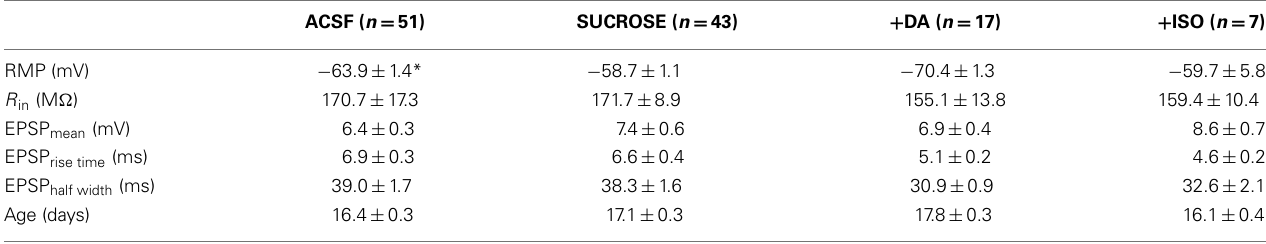
Figure 5E ; sucrose: 1.16 ± 0.2 ms ( n = 22) vs. ACSF: 0.4 ± 0.0 ms ( n = 9), p < 0.01 Student’s t -test], and latency of firing after the Table 1 | Basal electrophysiological parameters of neurons inACSF or sucrose prepared slices, and after dopamine or isoproterenol treatment of sucrose prepared slices.